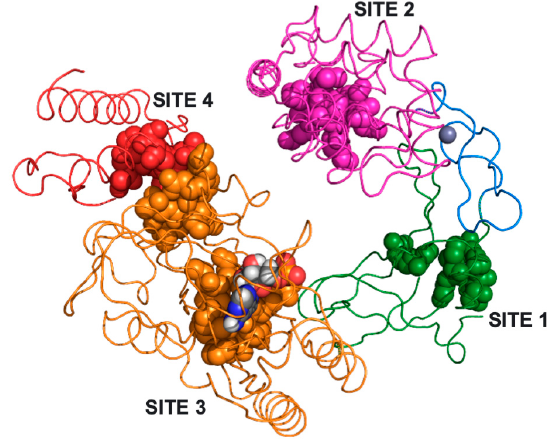
Figure 2. Potential inhibitor target sites in EC-LigA. Structure of EC-LigA (wire) coloured by domain (Ia, red; NTase, orange; OB-fold, green; Zn finger, blue; HhH, magenta) (PDB 2OWO [16] with the nicked DNA removed). The amino acids forming small molecule accessible sites (spheres, coloured according to domain location) were identified using the MOE site-finder tool. The sites are labelled SITE 1 to SITE 4. The AMP from the nicked DNA-adenylate (shown as spheres: grey, carbon; red, oxygen; blue, nitrogen; white, hydrogen) binds in the AMP-binding pocket within SITE 3. A Zn 2+ ion (purple sphere) is coordinated by the Zn finger domain.